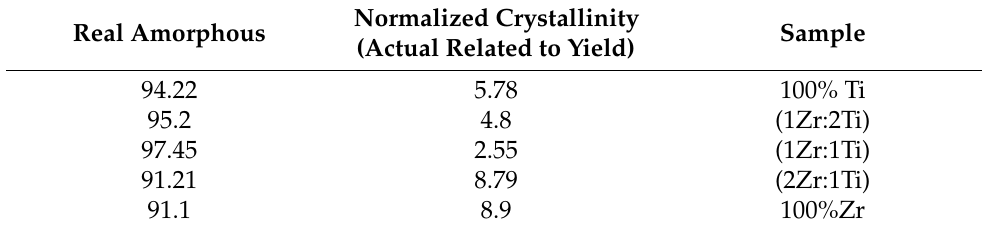
Table 4. Normalized real crystallinity against real amorphous